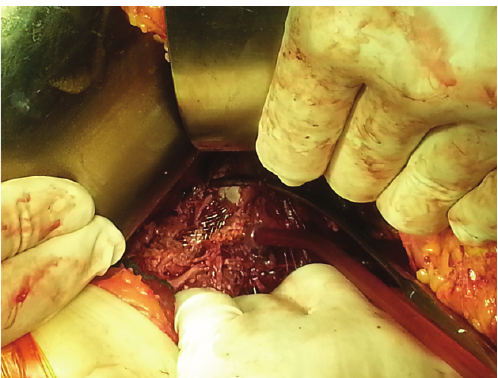
Figure 2: Perioperative finding: destructed wall of a right common iliac artery around bare metal vascular